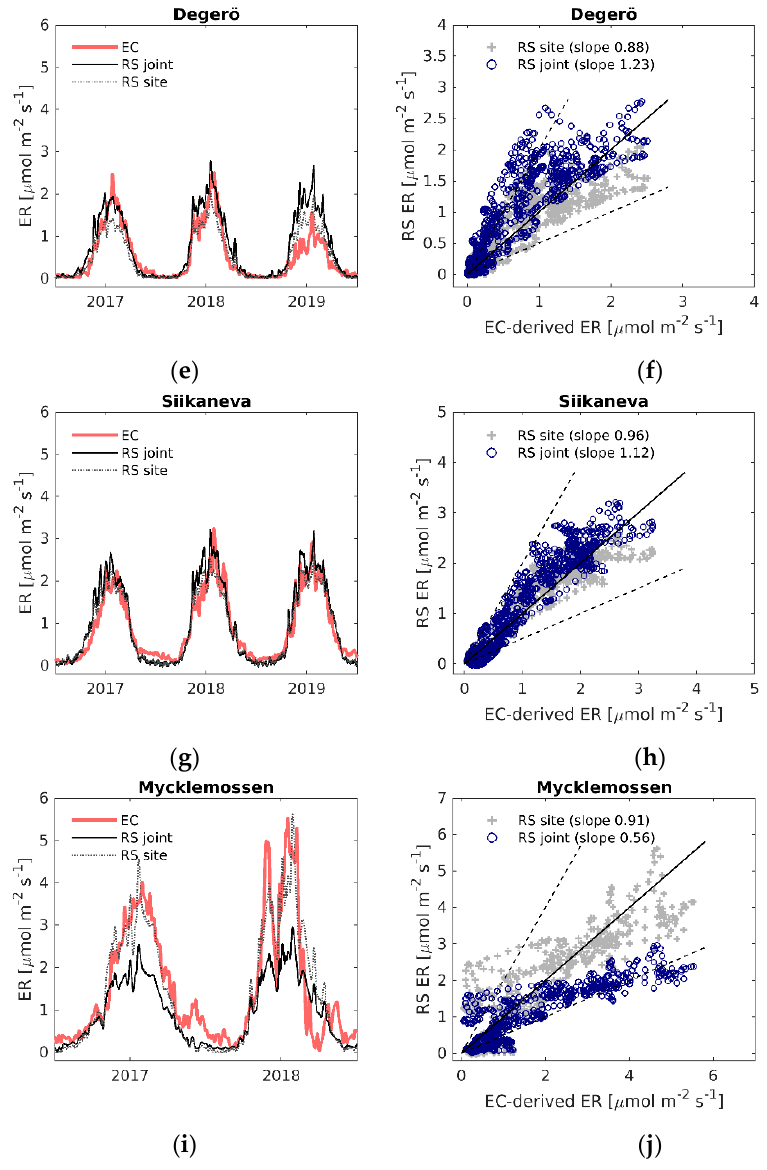
Figure 5. ( a , c , e , g , i ) Daily time series of EC-derived ER (EC), modelled ER using the LOOCV parametrization (RS joint) and modelled ER with the site-specific parameters (RS site); ( b , d , f , h , j ) EC-derived ER versus modelled remote sensing ER. Black solid line is the 1:1 line, black dashed lines are the 1:2 and 2:1 lines.